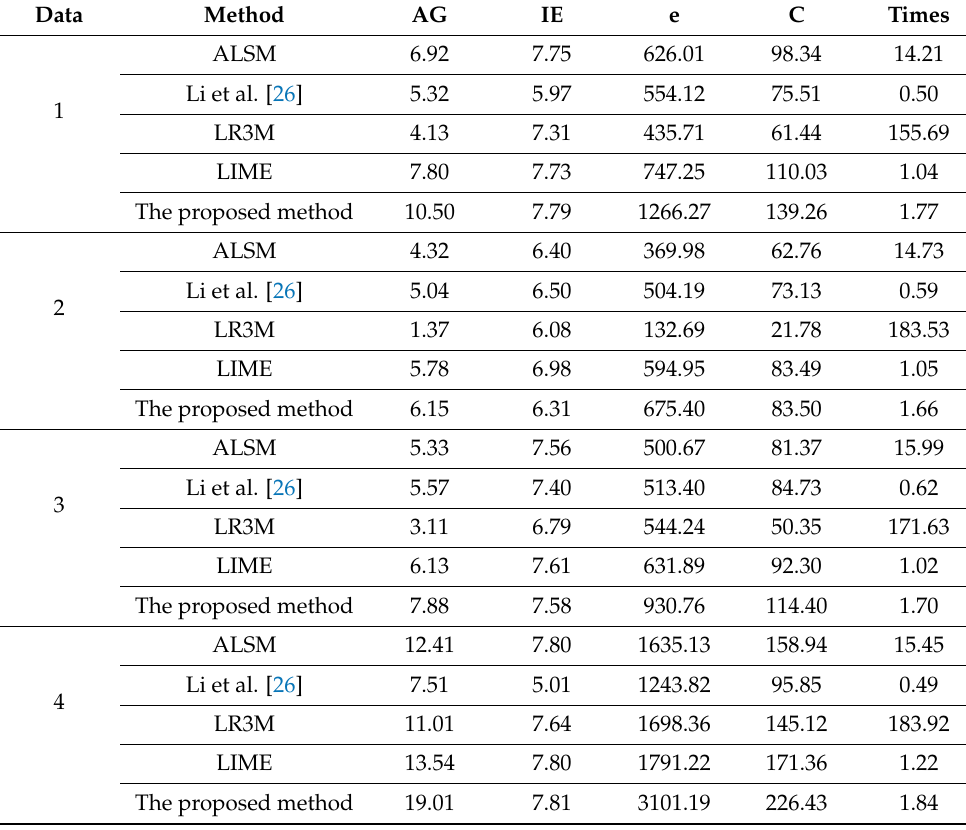
Table 4. Comparison of various indexes of captured data enhanced by different methods.